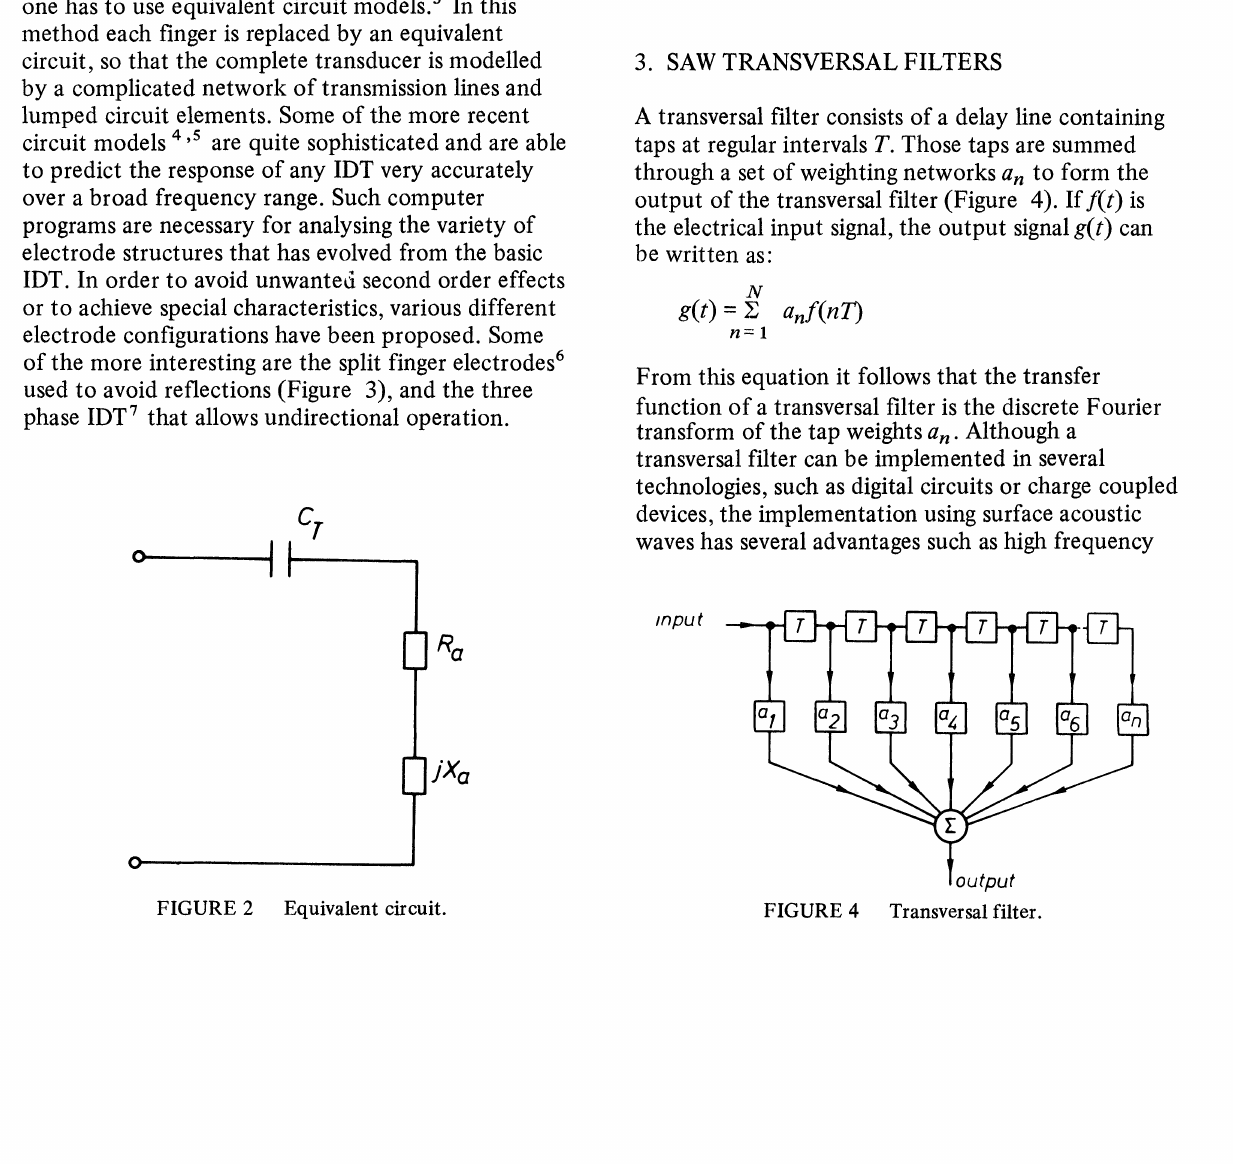
FIGURE Interdigital transducers.